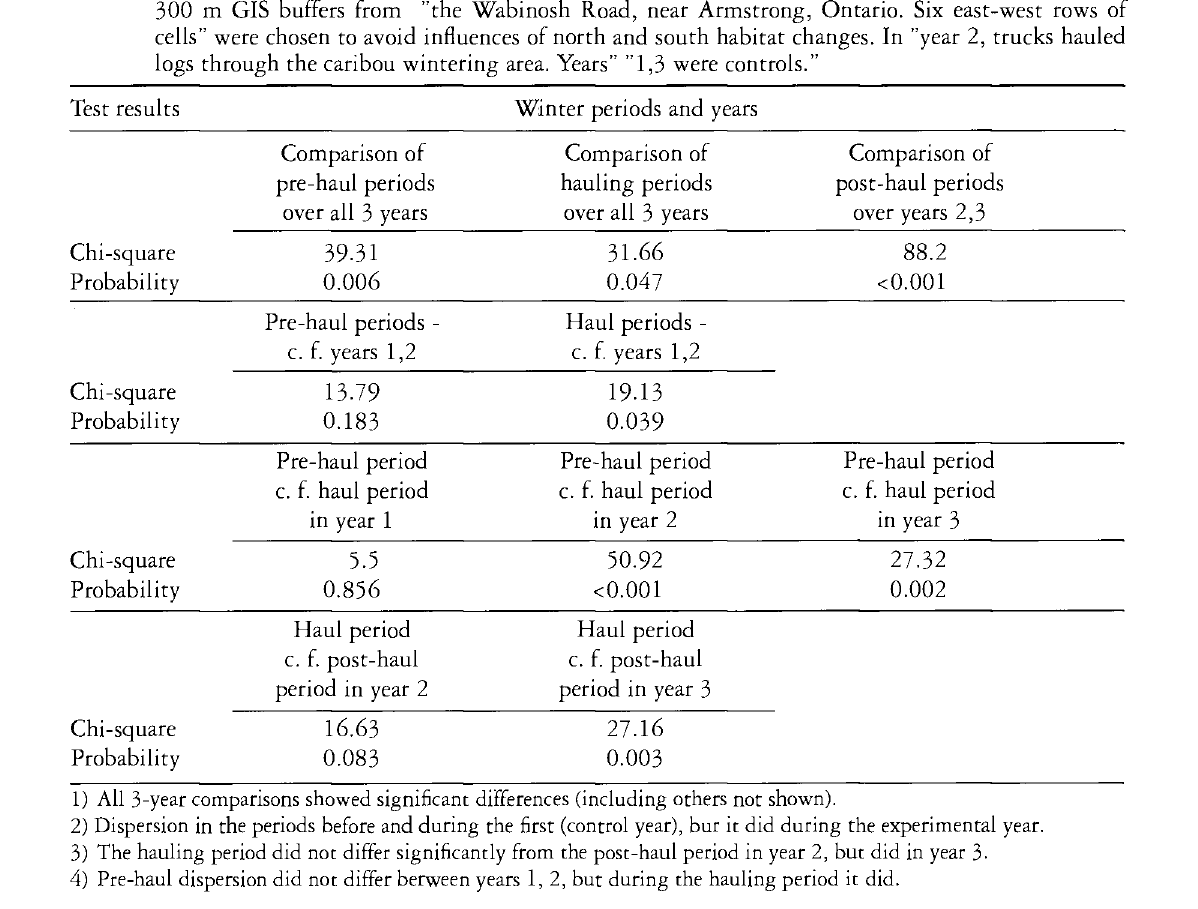
Table 4. Chi-square values and probabilities for proportions of cells occupied by caribou or caribou tracks in 1-9 300 m GIS buffers from "the Wabinosh Road, near Armstrong, Ontario. Six east-west rows of cells" were chosen to avoid influences of north and south habitat changes. In "year 2, trucks hauled logs through the caribou wintering area. Years" "1,3 were